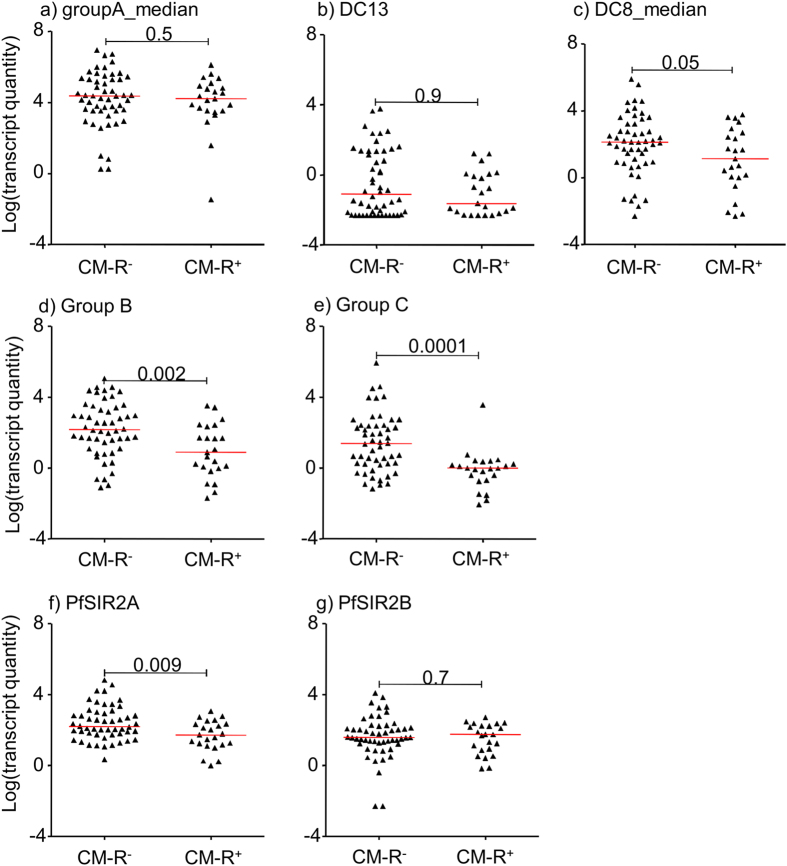
var transcript quantity and retinopathy.Dot plots showing the transcript quantity of different var subsets and Pfsir2 in parasites from children with cerebral malaria either without or with retinopathy (CM-R– and CM-R+). Each dot represents a single isolate. GroupA_median = is the median transcript quantity obtained with primers gpA1 and gpA2 (Table S1). DC8_median is the median transcript quantity obtained with the four-dc8 targeting primers. Group B and C represent the transcript quantity obtained with the primers b1 and c2 (Table S1). The red horizontal bar is the overall median. Significance of difference between CM-R– and CM-R+ are indicated as p values calculated using the Mann-whitney U test.